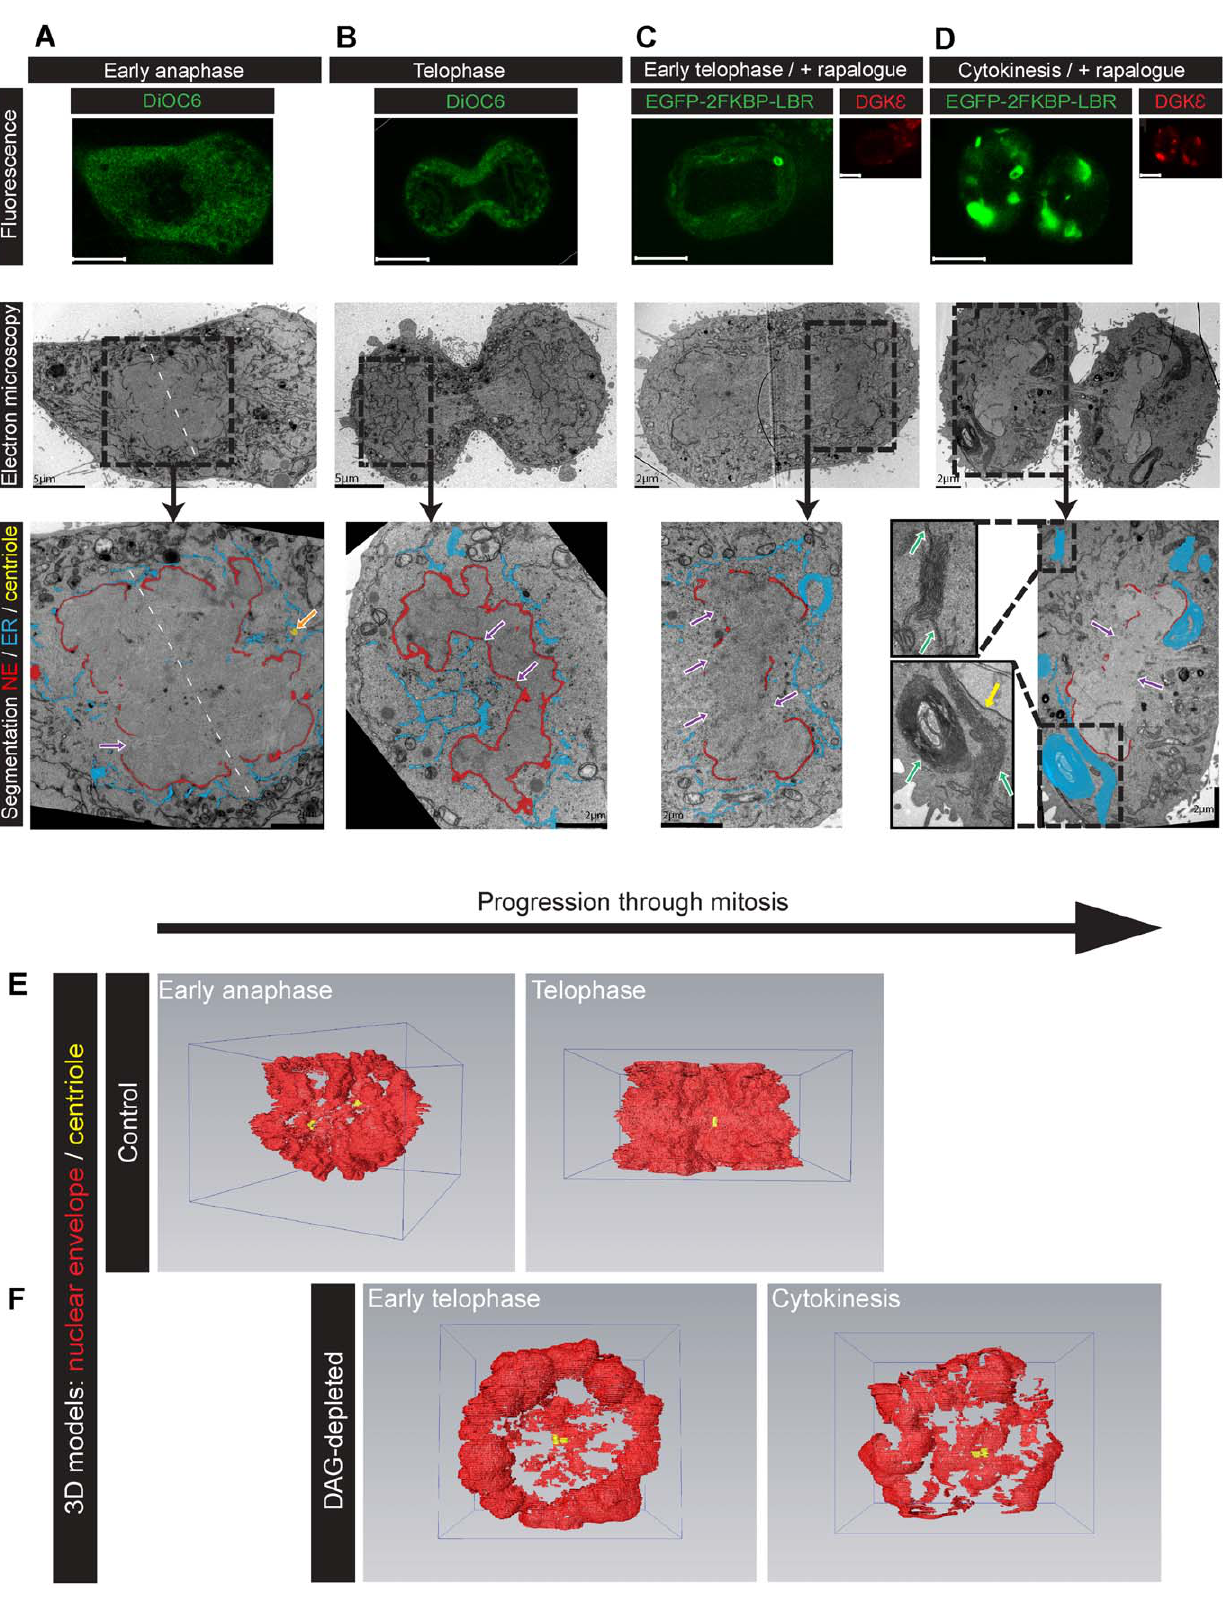
Figure 4. NE reformation is disrupted in a dose-dependent manner in DAG-depleted mitotic cells. (A–B) HeLa cells labelled with DiOC 6 (green) were followed through mitosis by confocal microscopy, fixed at early anaphase (A) or telophase (B) and prepared for high-resolution imaging using CLEM (Fig. S4). The segmentation showed that at early anaphase the NE (red) was incomplete with wide gaps of 4 to 5 m m (purple arrows), at